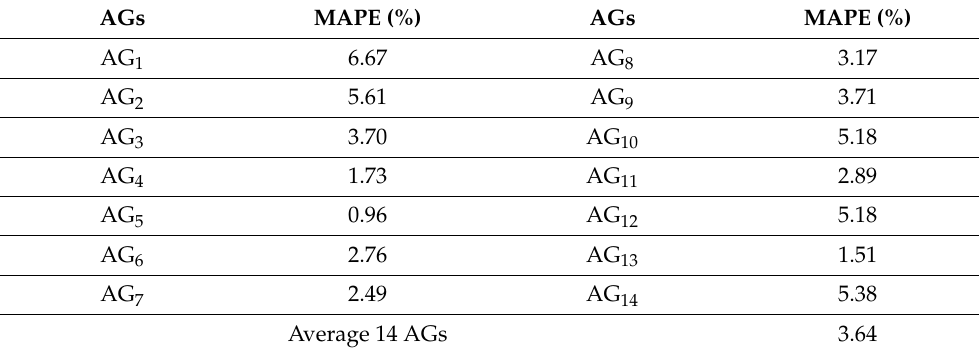
Table 13. MAPE results.